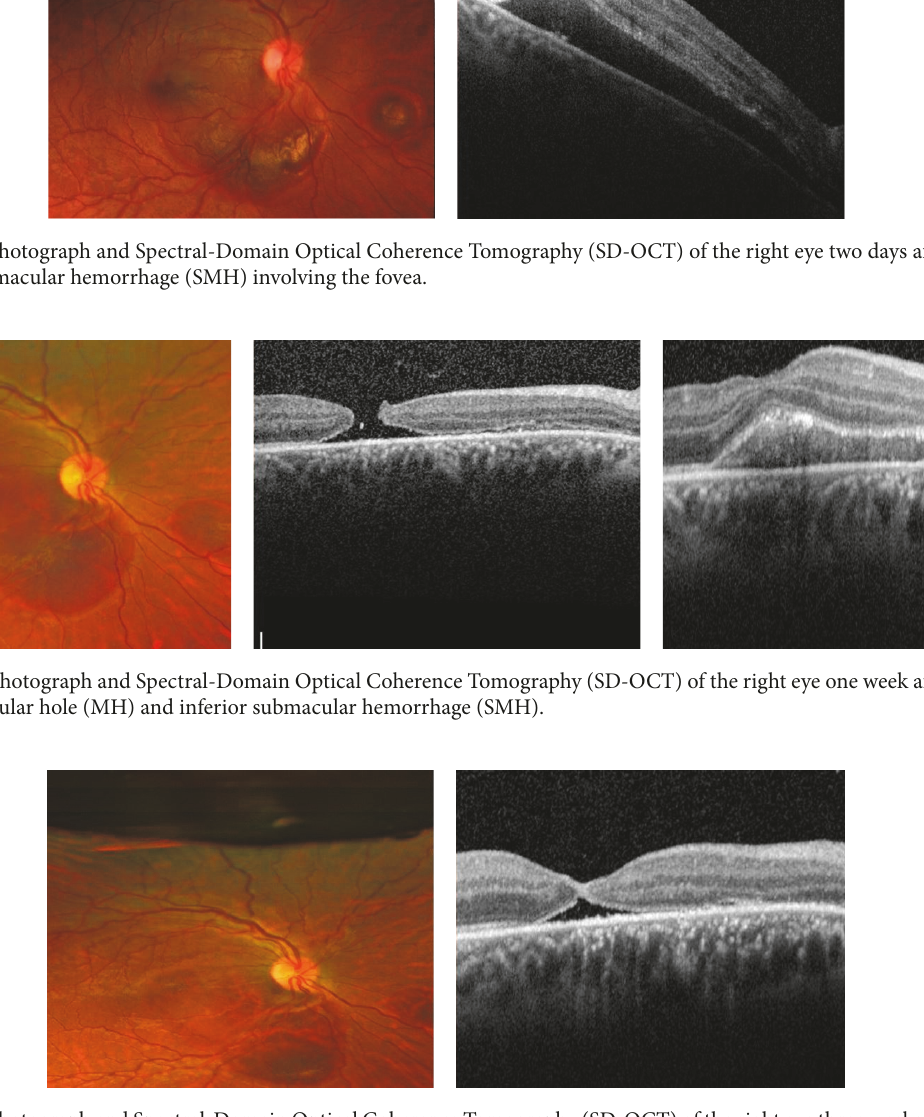
Figure 3: Fundus photograph and Spectral-Domain Optical Coherence Tomography (SD-OCT) of the right eye three weeks after intravitreal injection of C3F8 gas and t-PA demonstrating closure of macular hole (MH) and inferior displacement of submacular hemorrhage